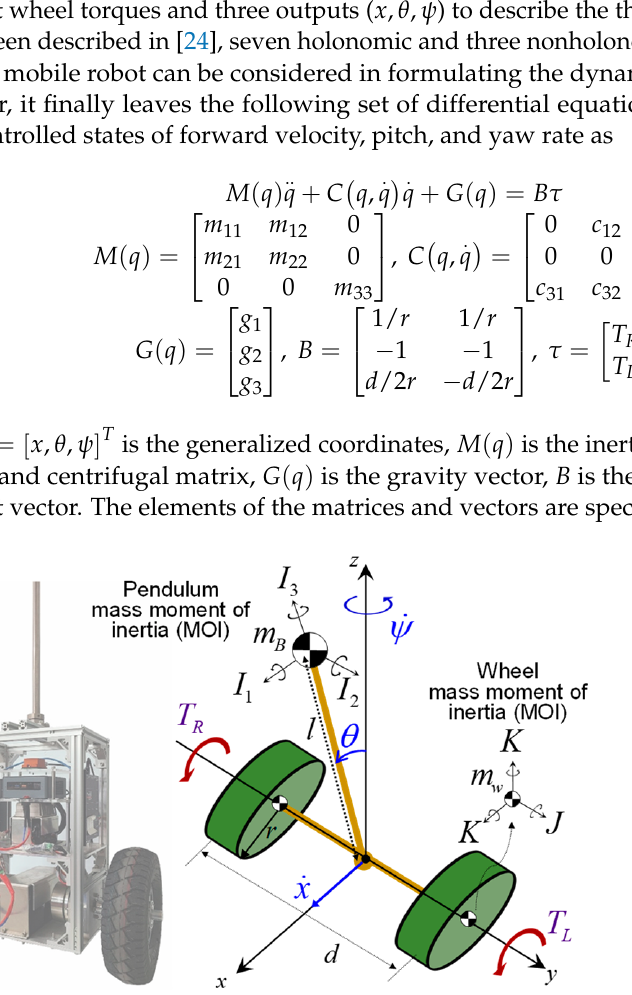
Figure 1. Prototype and schematic of TWIP with two parallel wheels. Table 1. Variables and parameters of TWIP robot. x Displacement along the forward direction